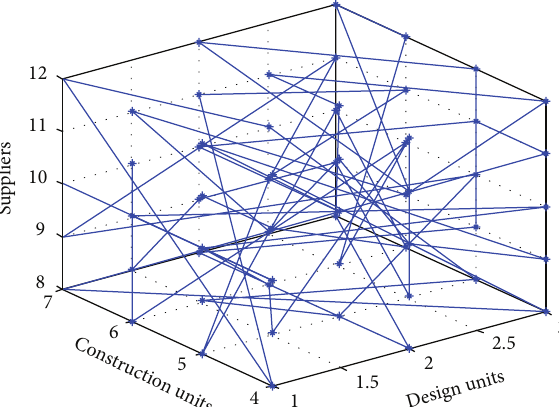
Figure 7: Case 1 : selection schemes of design units, construction units, and suppliers in construction contractors under the circumstance of individual performance and collaborative performance of the candidate units have the same weight, namely, 𝜆 = 𝜇 = 0.5 .